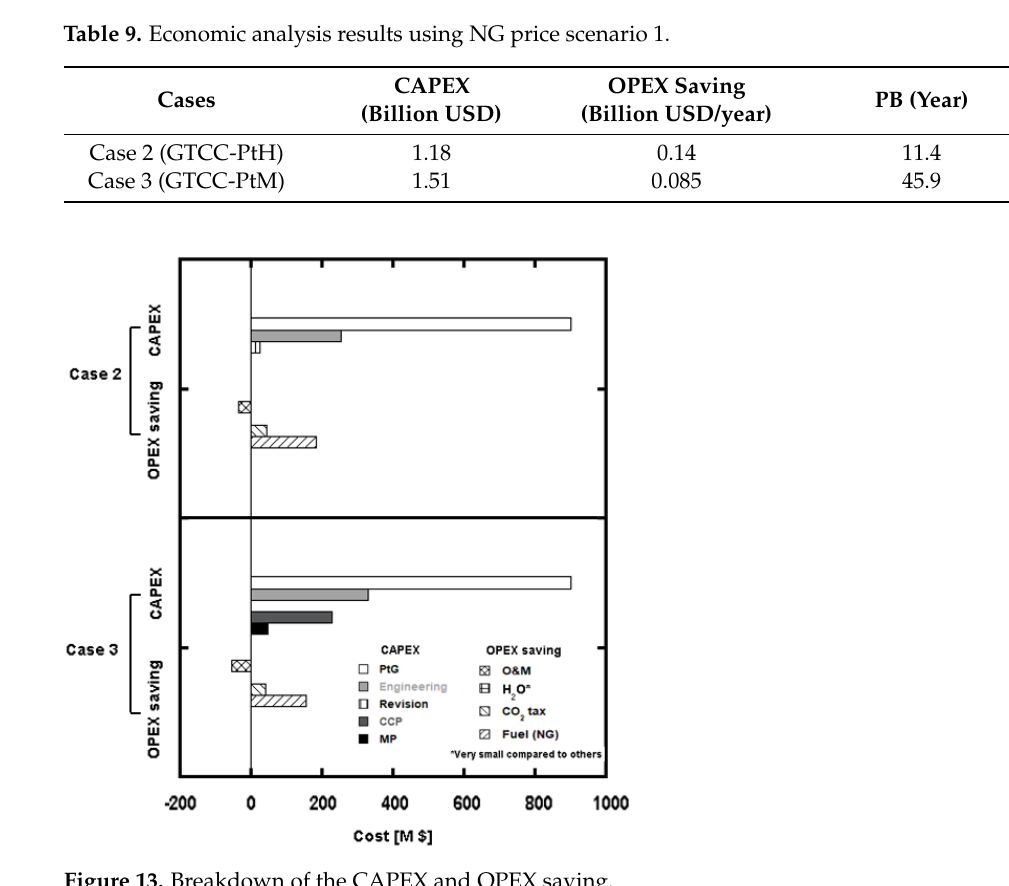
Figure 13. Breakdown of the CAPEX and OPEX